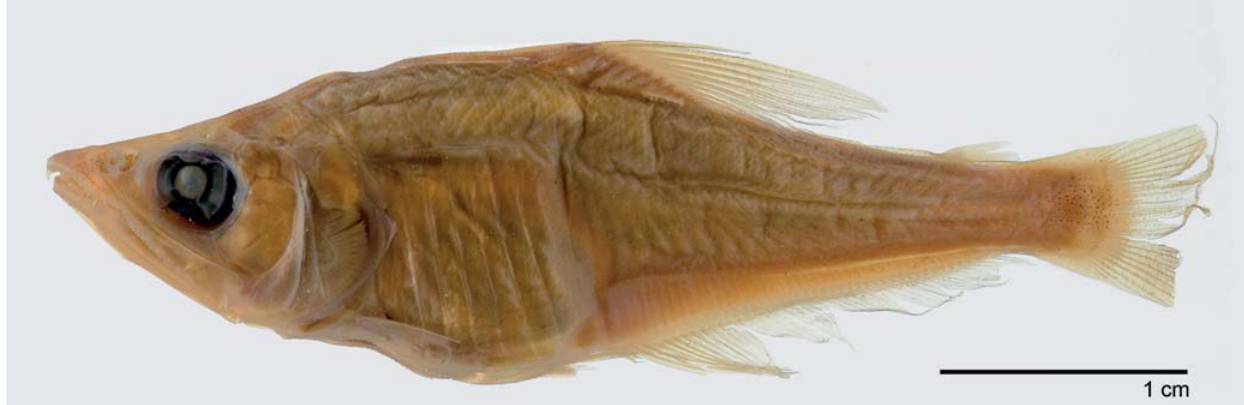
Fig. 1. Galeocharax goeldii , ANSP 39308, holotype, 44.3 mm SL, tributary of Madeira River near Porto Velho, Brazil.